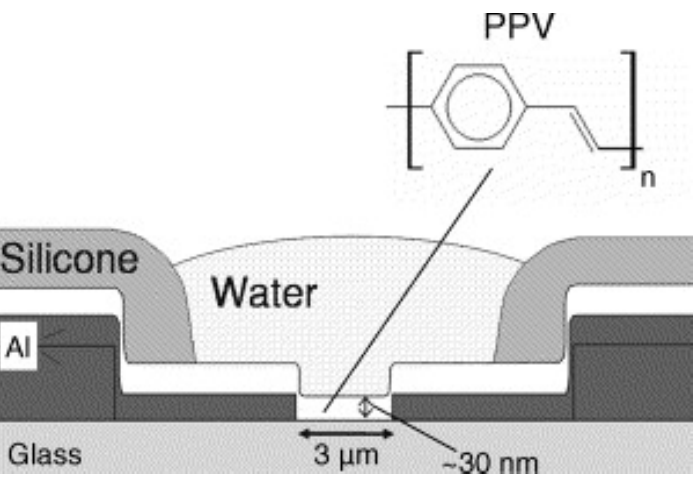
Figure 6. Schematic drawing of the pH sensitive device showing the aluminum contacts (dark grey) below a thin (30 nm) layer of PPV (white). In the wet state, a solution covers the whole area inside the pool formed by the silicone protection over the contact pads. Drawing is not to scale. Reprinted from [63] © 2007 with permission from